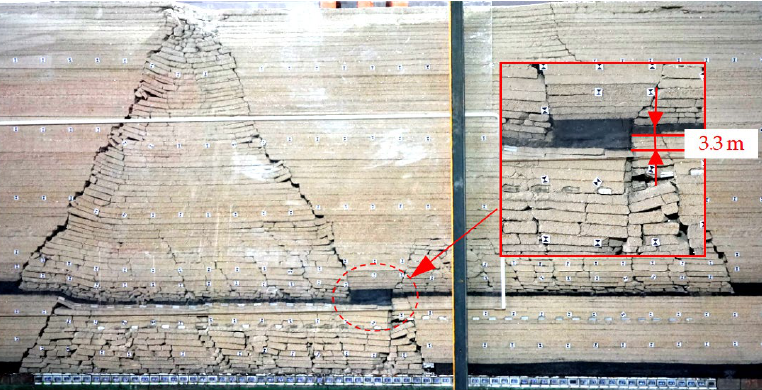
Figure 14. Subsidence of coal pillar and upper inverted trapezoidal structure after periodic weighting.